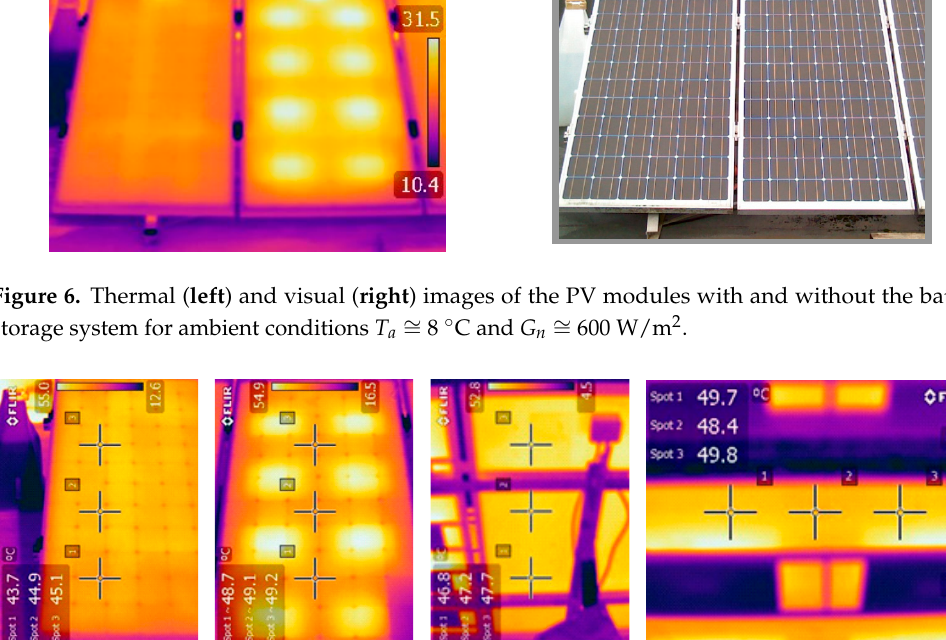
Figure 6. Thermal images of front and back sides of the PV modules, with and without the battery storage system for ambient conditions T a ≅ 15 °C and G n ≅ 900 W/m 2 .